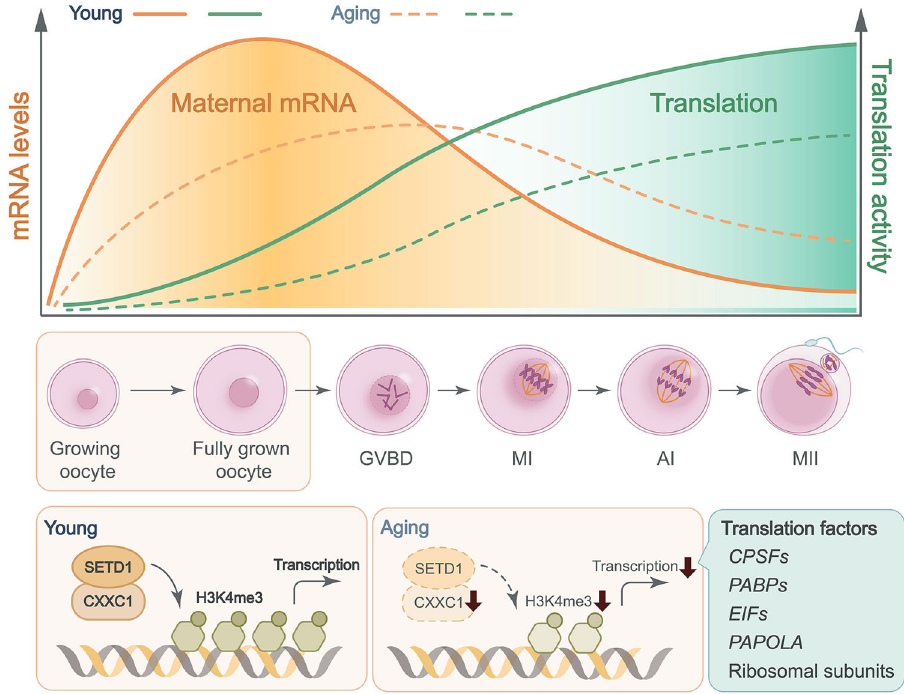
Fig. 10 CXXC1-maintained histone H3K4 trimethylation and meiosis-coupled mRNA decay mediate age-associated transcriptome changes in human oocytes. Meiotic maturation-coupled mRNA translation and decay are impaired in the oocytes of aged females. Histone H3K4 trimethylation level was high in fully grown oocytes derived from young women, but gradually decreased during the aging process. The decline of CXXC1-maintained H3K4me3 level led to a wide spectrum of aging-related phenotypes, including aneuploidy after meiotic division, organelle clustering, inef fi ciency of mRNA transcription, translation, and clearance, anovulation, and ultimately, female